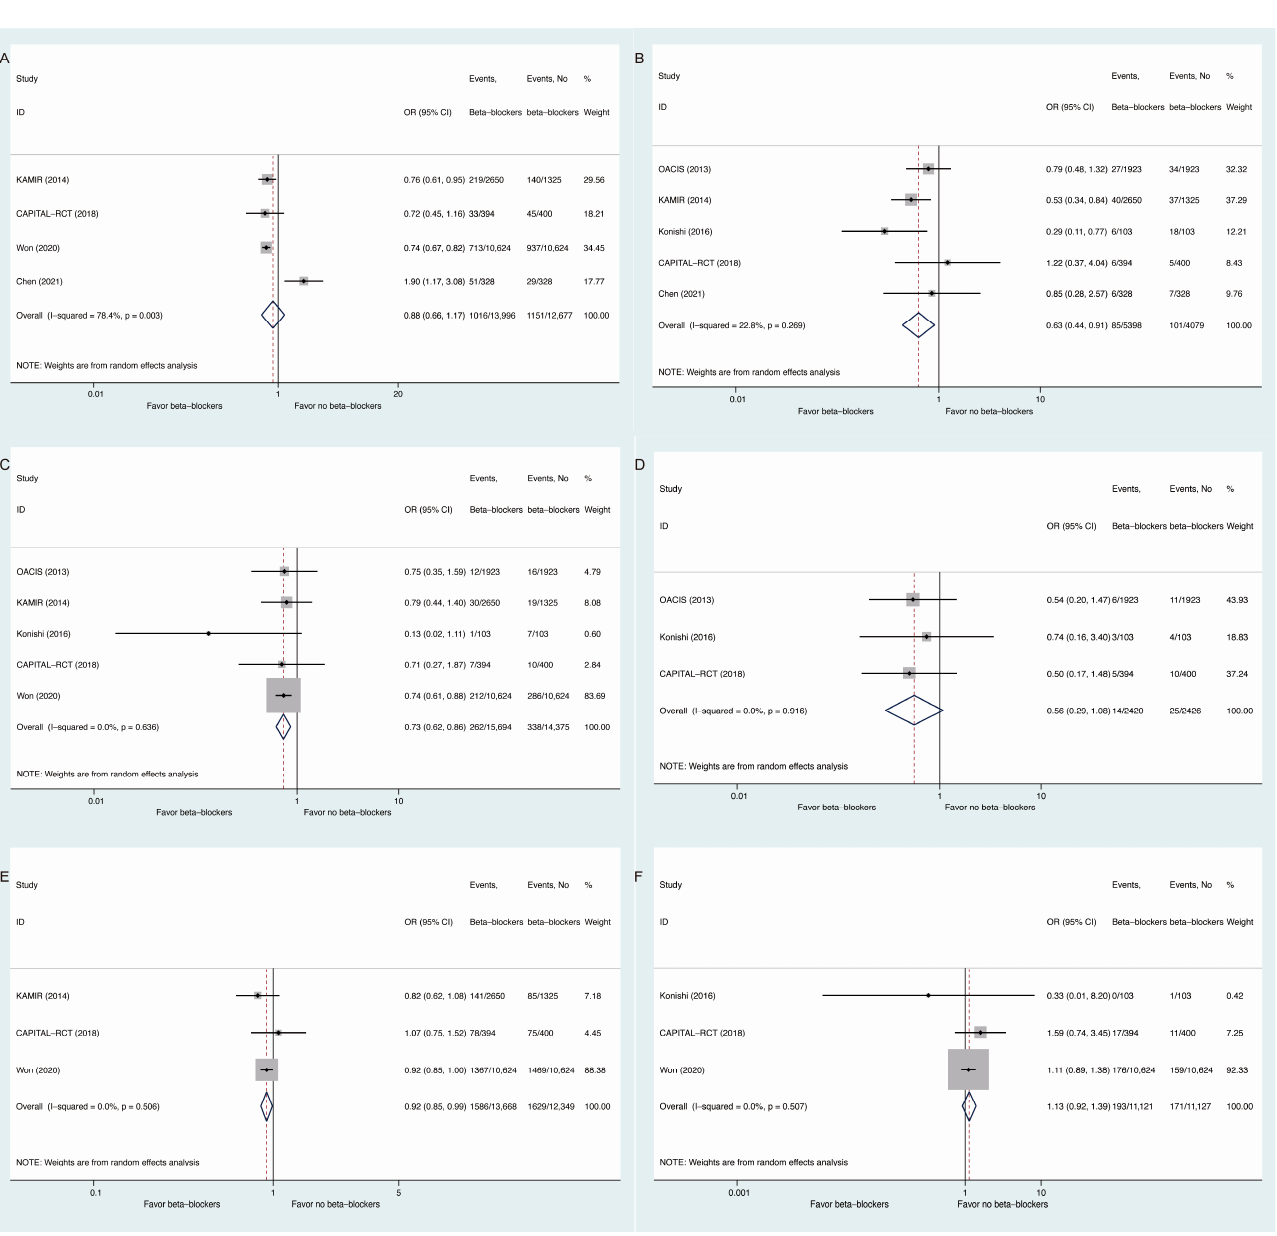
Figure 3. Comparisons of Secondary Outcomes Between Beta-Blockers and Controls: ( A ) major ad- verse cardiovascular events; ( B ) cardiac death; ( C ) myocardial infarction; ( D ) heart failure; ( E ) re- vascularization; ( F ) stroke.